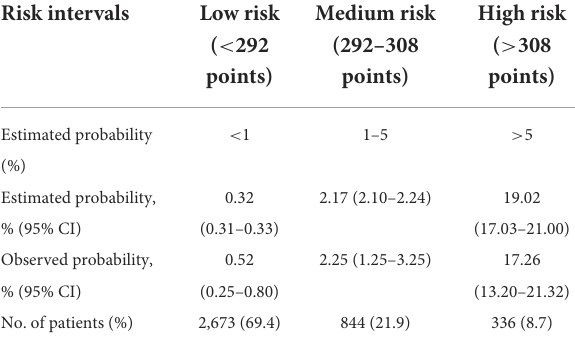
TABLE 3 Risk intervals of SH based on the nomogram and clinical